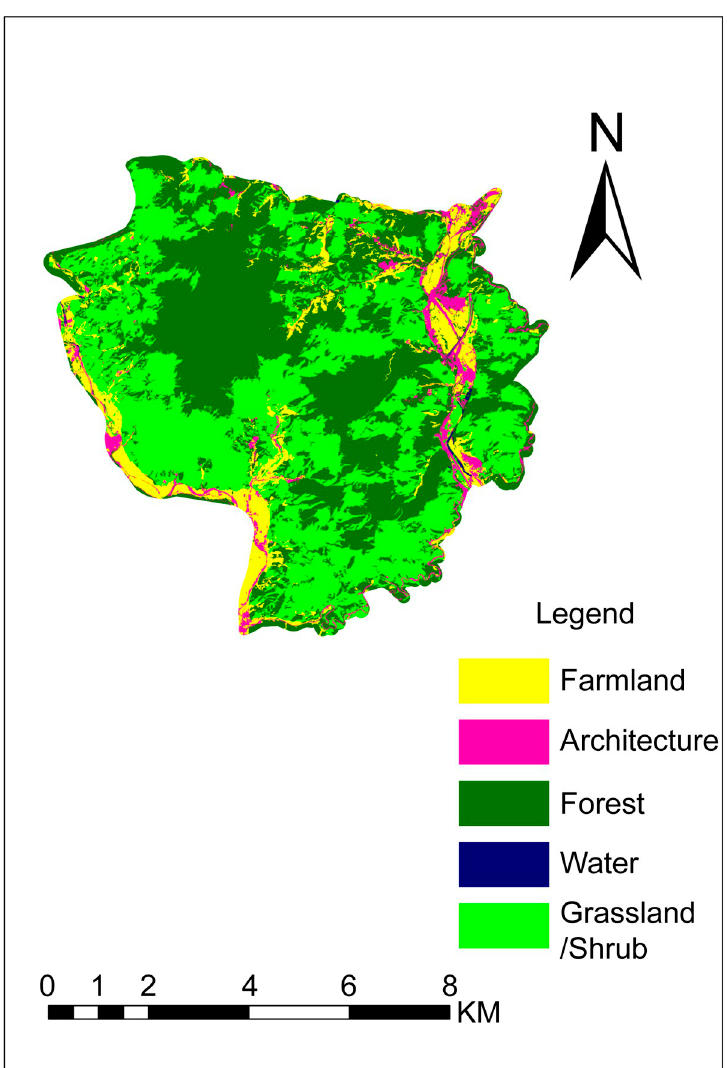
Fig 8. Object-oriented classification of Yugu Cave (Republished from [https://directory.eoportal.org/web/ eoportal/satellite-missions/g/gaofen-2] under a CC BY license, with permission from [Hebei Zhongke Sino Star Information Technology Co., Ltd], original copyright [2018]).